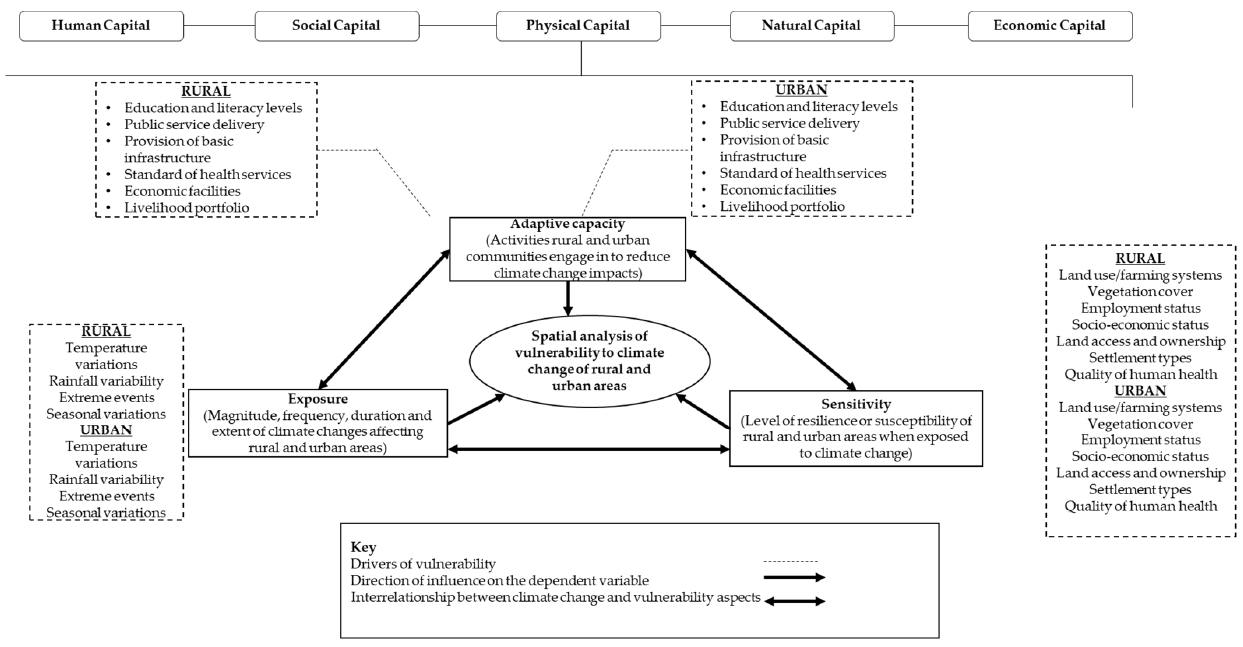
Figure 3. Conceptual framework of differences in vulnerability to climate change between rural and urban areas. Source: Authors’ conceptualisation.